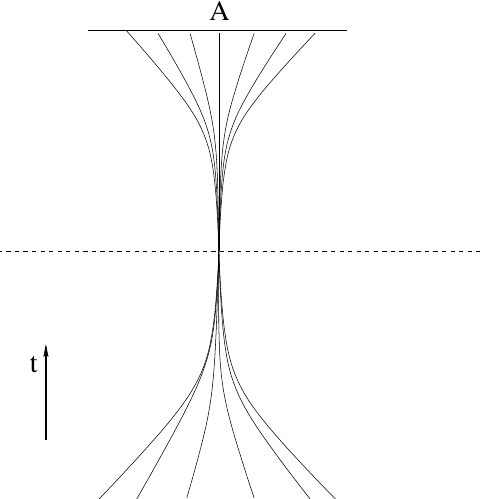
Figure 2. Final conditions required for an extension of geodesics through a hypersurface of signature change (dashed). A β approaching zero in the effective line element (39) implies that light cones in the Lorentzian region collapse. All timelike geodesics aimed toward a given point on the transition surface therefore arrive there with the same asymptotic direction. Using the limiting values as initial values for extended (now spacelike) geodesics in the Euclidean region, a unique extension follows only if additional data are provided, such as the final point of a spacelike geodesic. The final points for a family of geodesics, lined up in this figure along a curve A, correspond to the final data on the arc A in the Tricomi problem, Figure